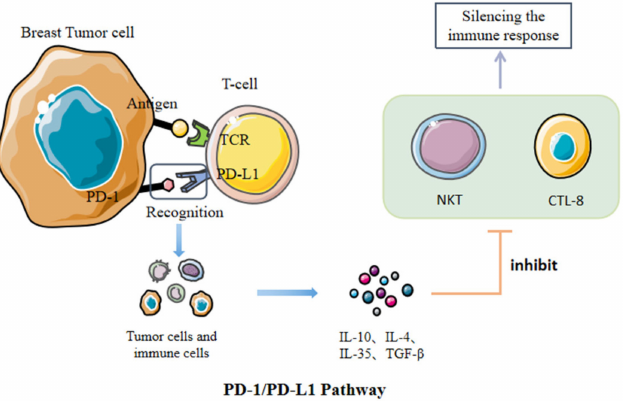
Figure 1. After the recognition of PD-1 and PD-L1, the immune escape of tumor cells can be realized by increasing the expression of inhibitory